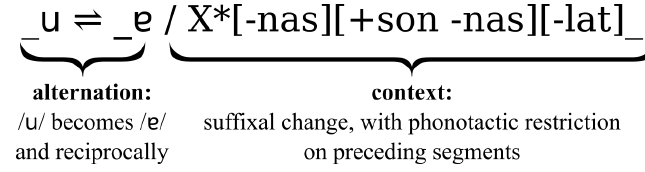
Figure 1: Structure of the alternation pattern instantiated by lexemes such as ter in Table 5 Notice that Qumín adapts notation from classical generative phonological rules (Al­ bright and Hayes, 2002; Chomsky and Halle, 1968); but, unlike classical rules, alternation patterns are bidirectional and can describe changes in more than one location in the